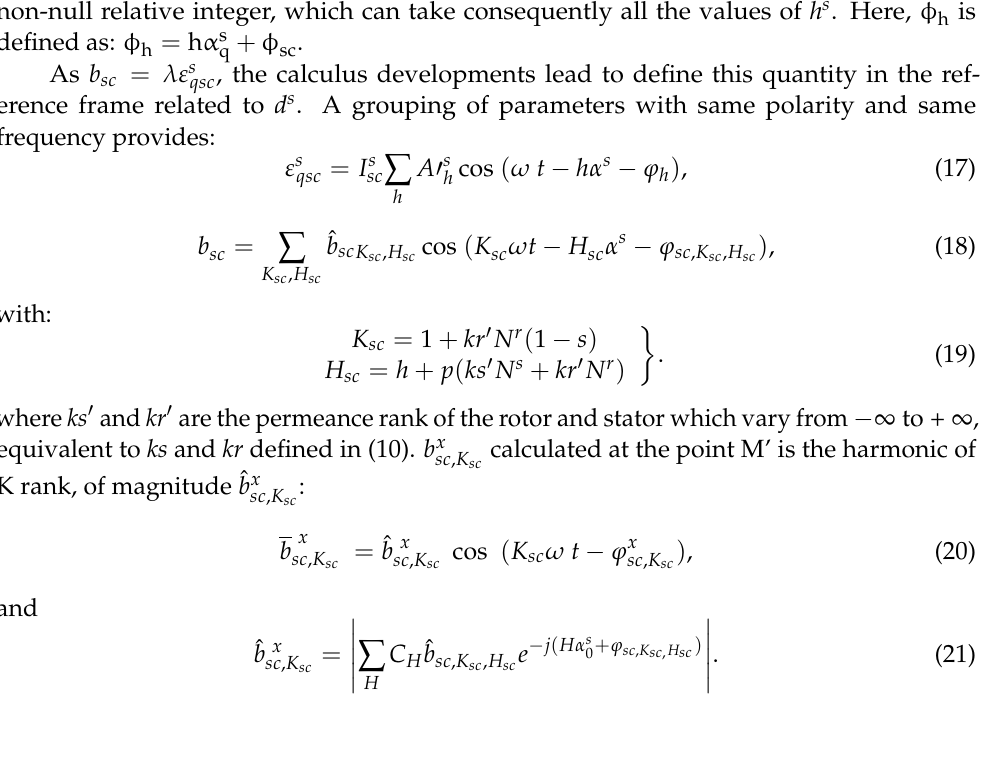
Figure 6. m.m.f generated by the faulty turns.